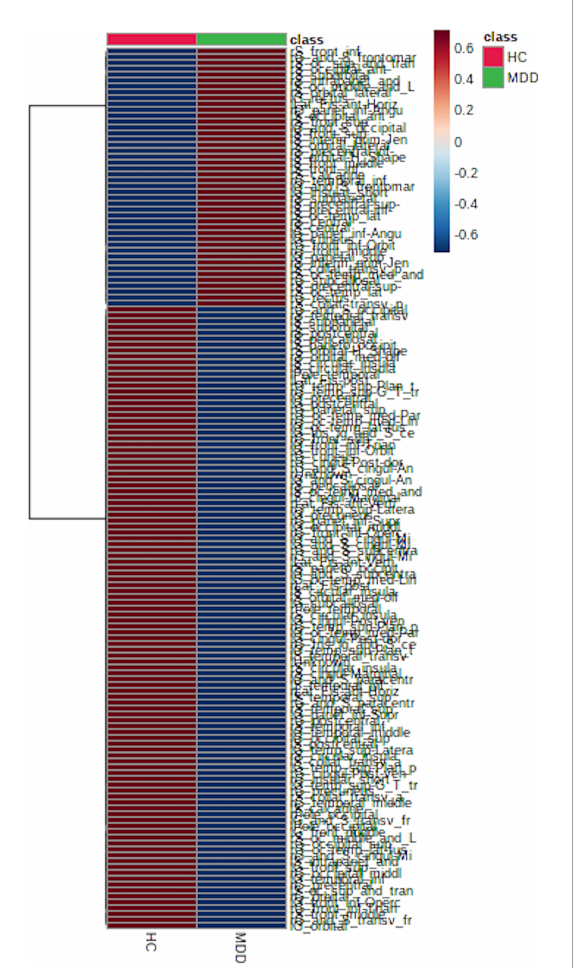
FIGURE1 Local gyrification index (LGI) between major depressive disorder (MDD) and healthy control (HC) groups. We found that 108 (approximately 71%) of the 152 LGIs were MDD < HC, which supports a decrease in LGIs in patients with